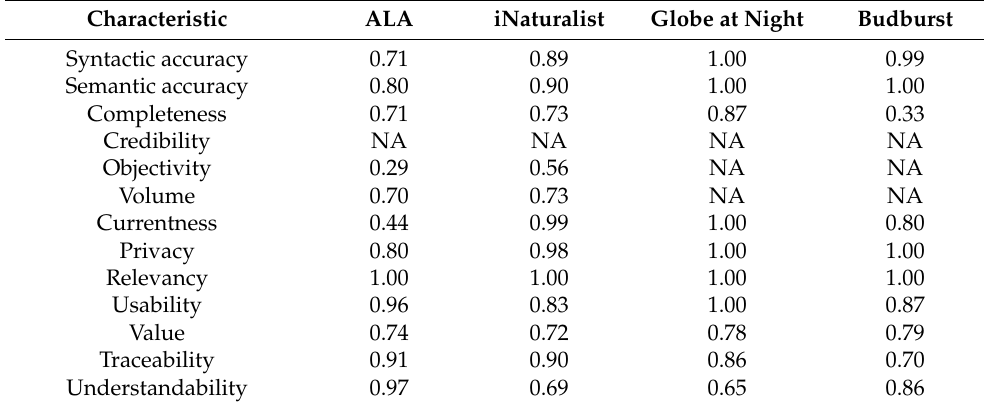
Table 4. RapidMiner query